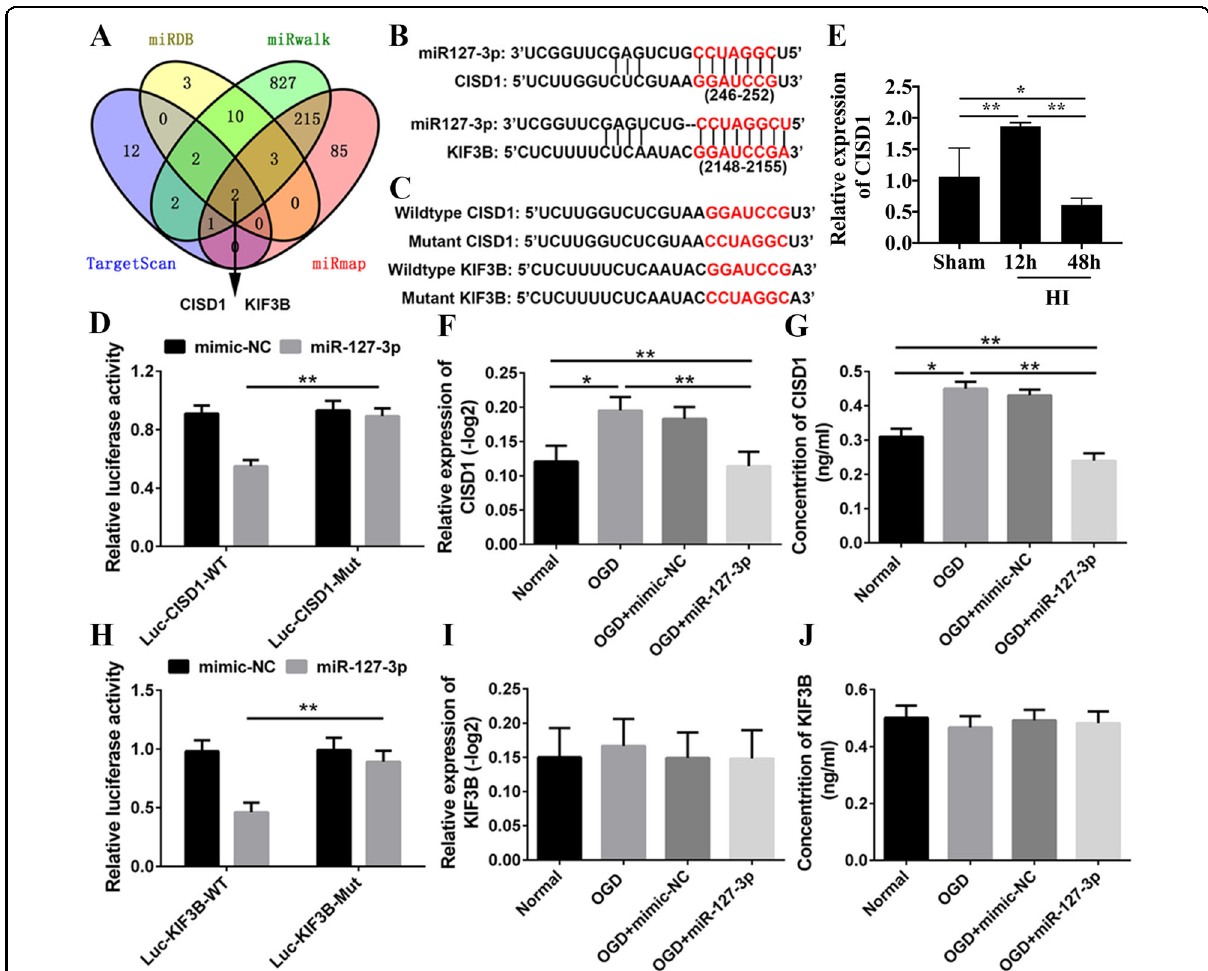
Fig. 5 The detection of the direct targets of miR-127. A Venn diagram of target genes of miR-127-3p which derived from conventional online programs of miRDB, TargetScan, miRwalk and miRmap. CISD1 and KIF3B are the common targets of miR-127-3p in the four conventional online programs which were selected for further investigation. B The alignment of the seed regions of miR-127-3p with CISD1 and KIF3B. C The wildtype and mutation alignment sequence of CISD1 and KIF3B. D Luciferase activity of CISD1 was detected at 48 h after transfection. Relative luciferase activity was calculated with (RlucmiRNA/hLuc miRNA)/(Rluc NS-miRNA/hLuc NS-miRNA). E qRT-PCR analysis of CISD1 expression at 12 and 48 h after HI injury. F , G The relative expression and concentration of CISD1 were detected. H Luciferase activity of KIF3B. I , J The relative expression and concentration of KIF3B were detected. * P < 0.05, ** P < 0.01 with one-way ANOVA, n =